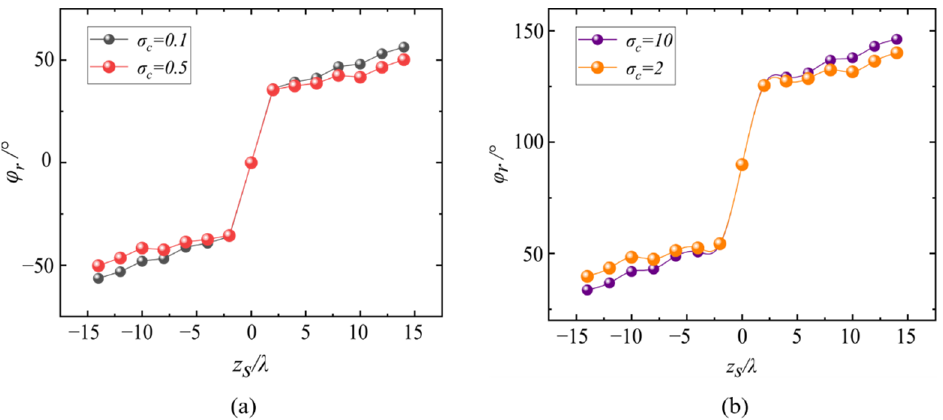
Figure 3. Definition of a rotational angle 𝜑 (cid:3045). Here, 𝜎 (cid:3030) = 0.5, 𝑙 = 1, 𝑧 (cid:3046) = −4 .